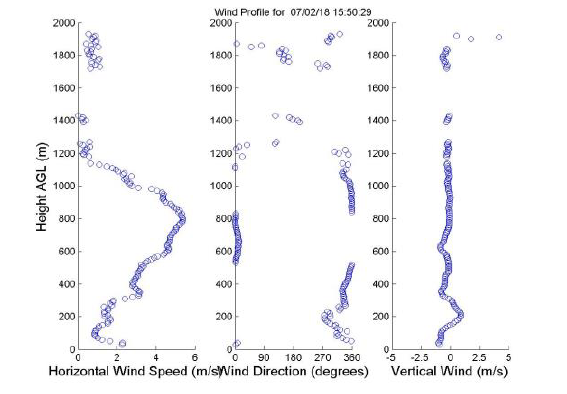
Fig. 6a Halo Pro profiles at 11:30 EDT